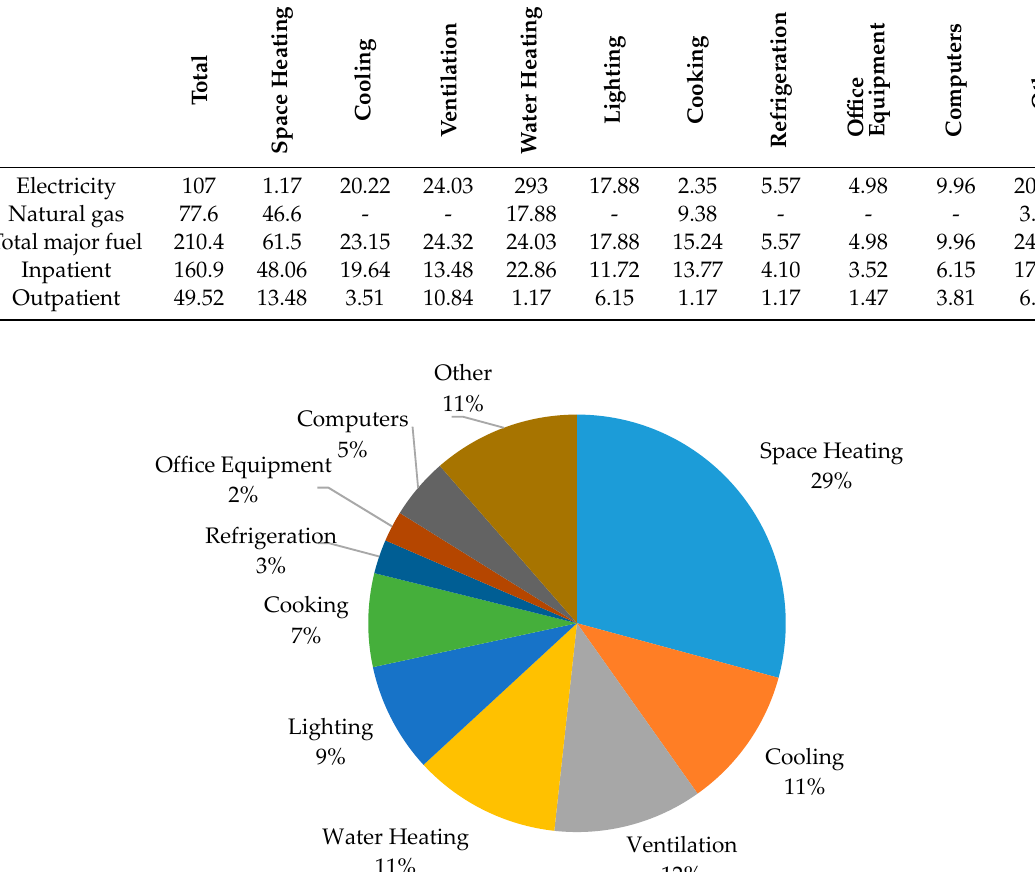
Table 1. Energy consumption by end-use type in billion (10 9 ) kWh.